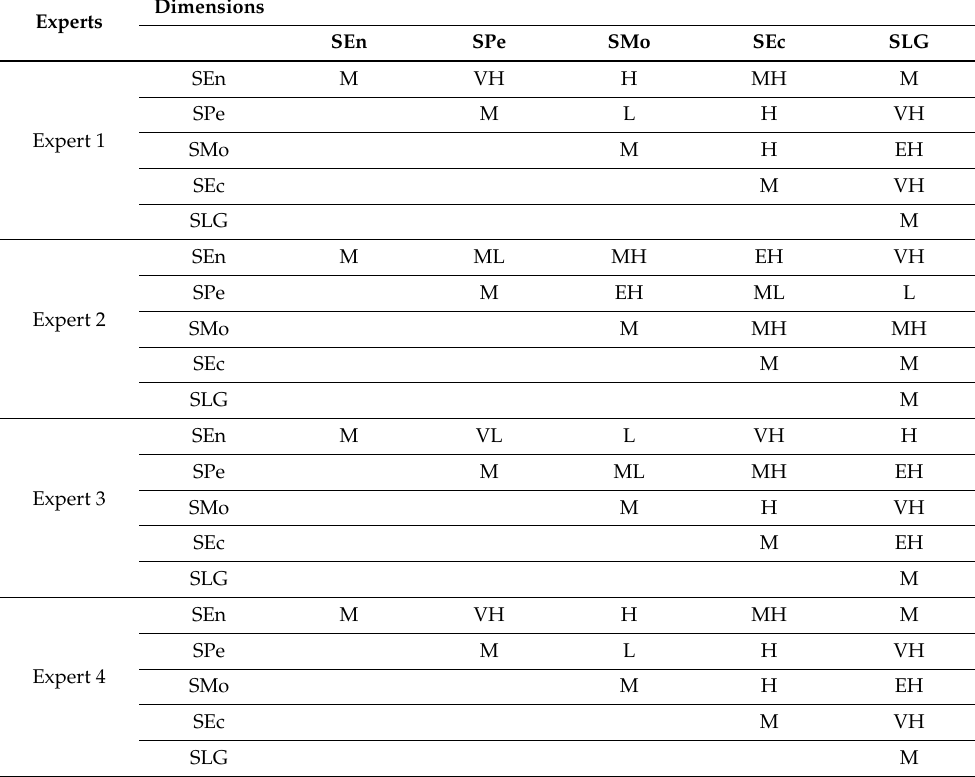
Table A1. The Experts judgments for the principal dimensions using linguistic variables.